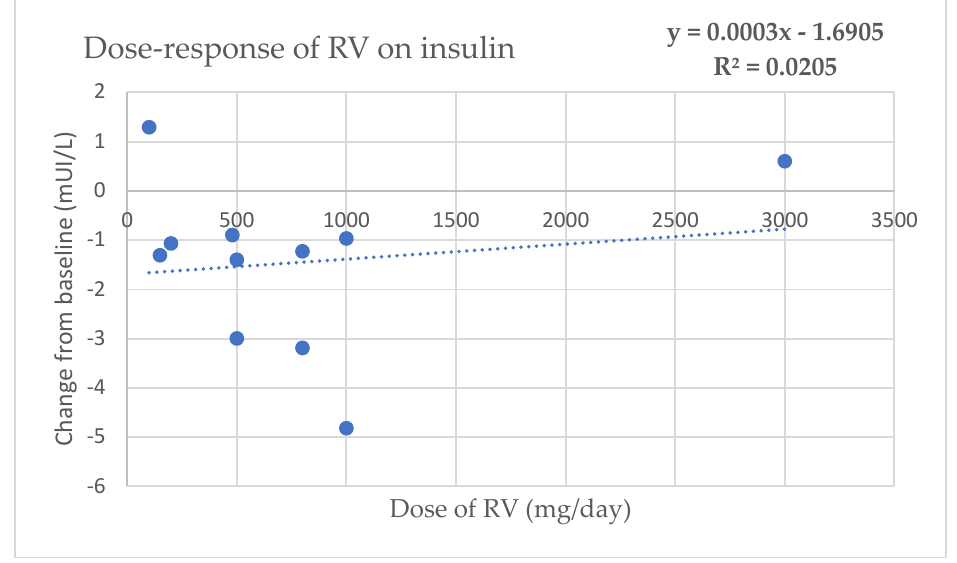
Figure A3. Dose–response regression analysis to assess the effect of RV on serum insulin levels.